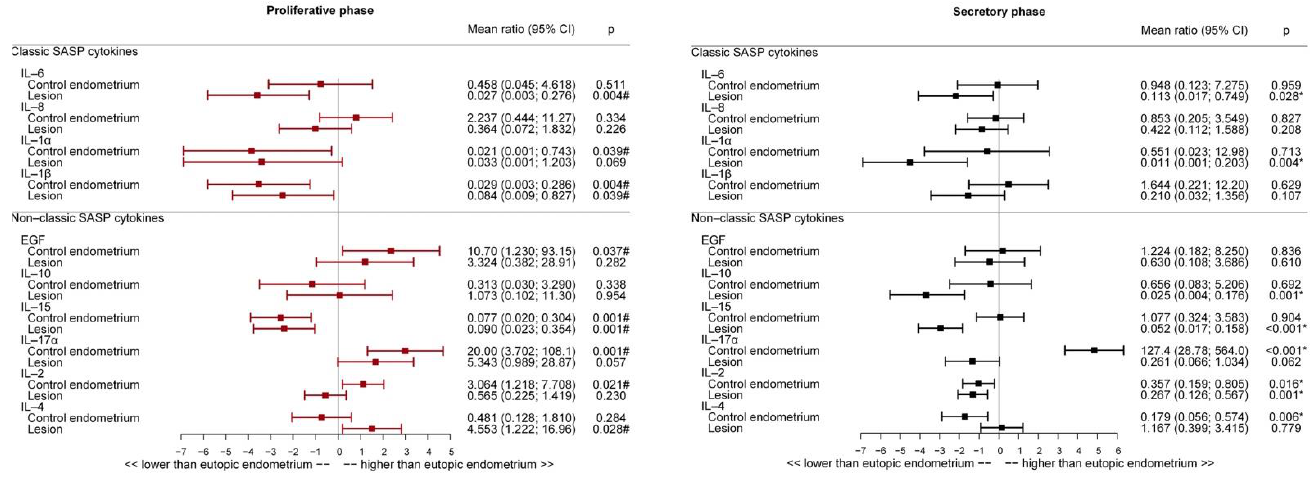
Figure 3. Senescence-associated secretory phenotype (SASP) and cytokine expression (pg/mL) according to tissue type (non-endometriosis endometrium, eutopic endometrium, and endometriosis lesion). * p < 0.05, compared to the eutopic endometrial group in the secretory phase. # p < 0.05, compared to the eutopic endometrial group in the proliferative phase.